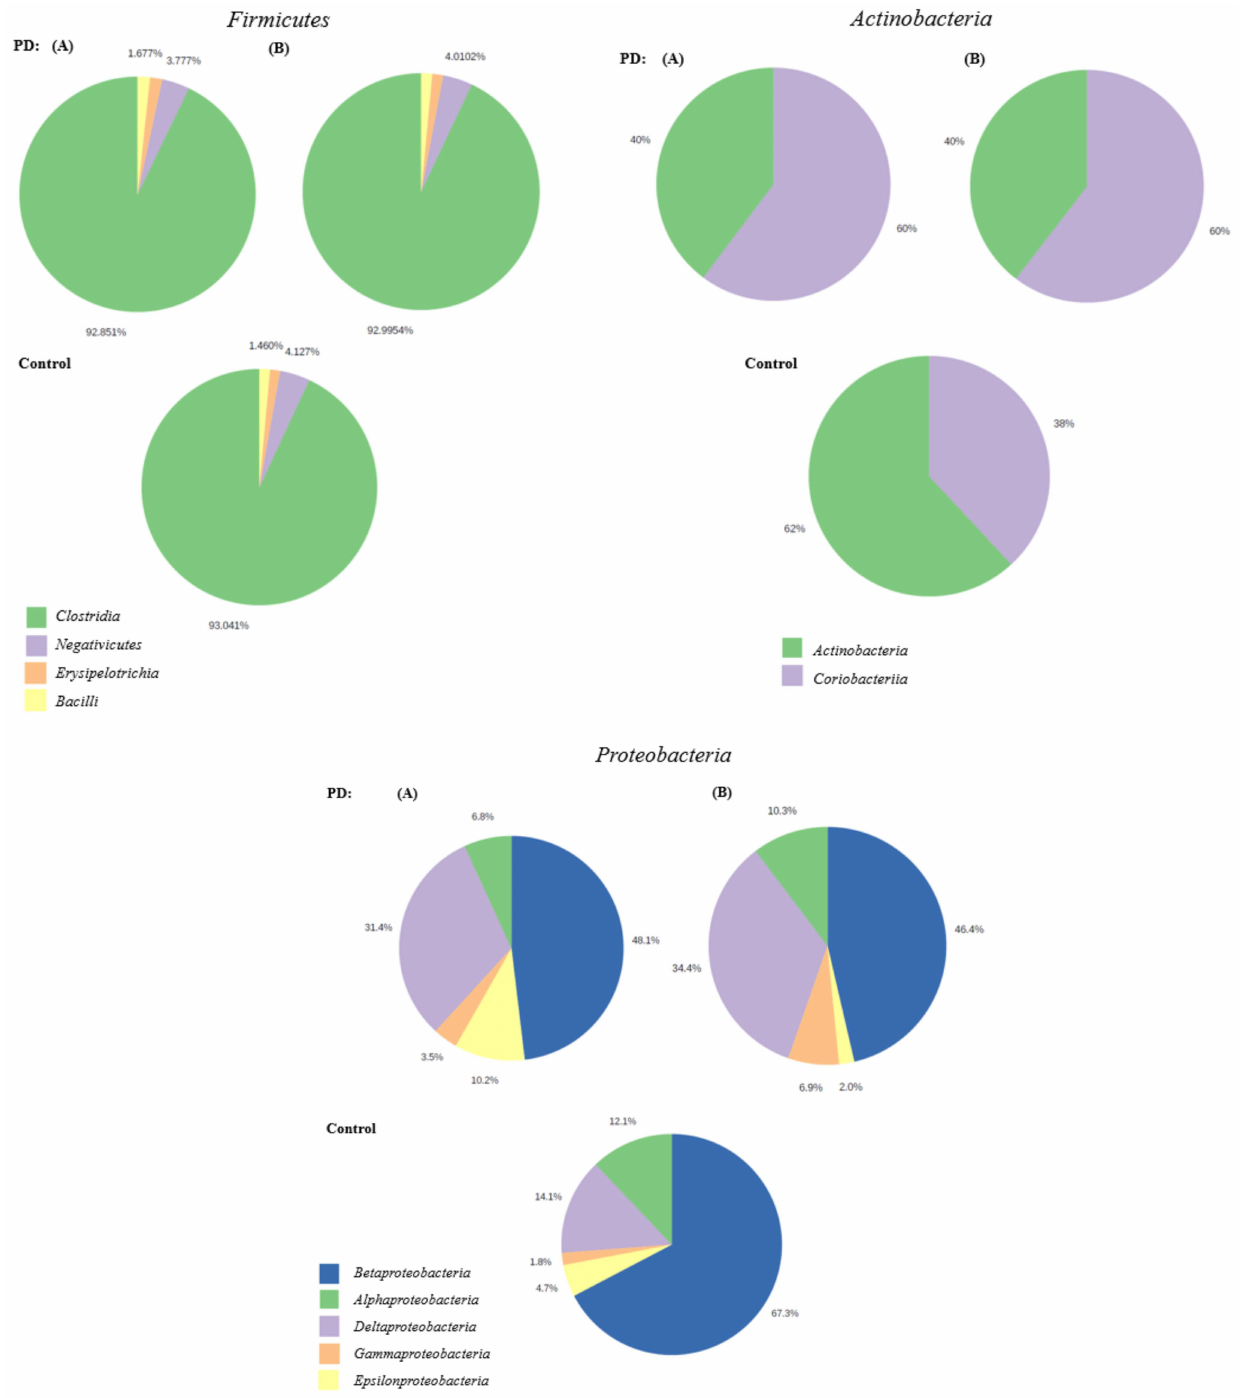
Figure 4. Pie charts presenting the comparative abundance profiles across two groups PD and control at class level in the phyla Firmicutes , Actinobacteria , and Proteobacteria . Pie charts with (A) represent the study group diagnosed with PD and other diseases (such as hypertension and diabetes), the pie charts with (B) represent the study group diagnosed with PD and without other